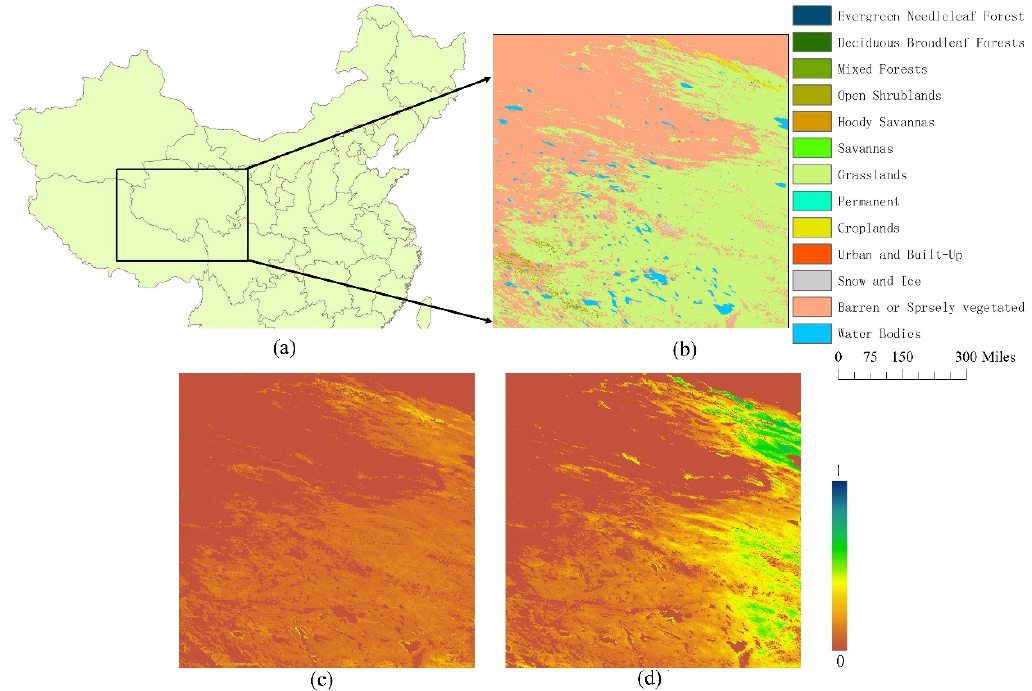
Figure 5. Information of the study area and monthly averaged FVC estimation maps by the proposed algorithm in 2015: ( a ) location of the study area over China, ( b ) land cover data of MCD12Q1 (IGBP) for the study area, and ( c , d ) FVC estimations generated by the proposed algorithm in January and July, respectively.